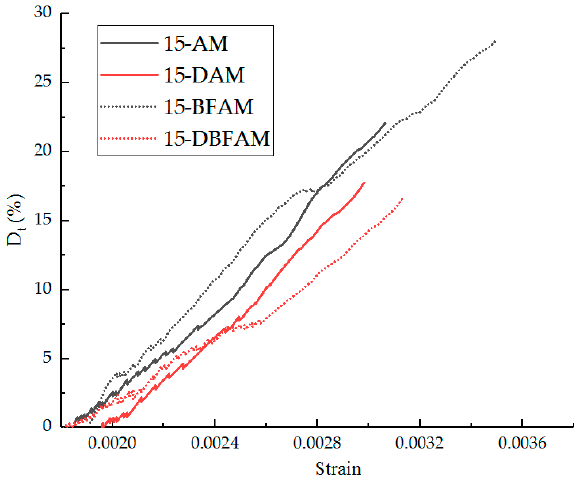
Figure 19. D t values in the nonlinear zone after 15 F–T cycles.